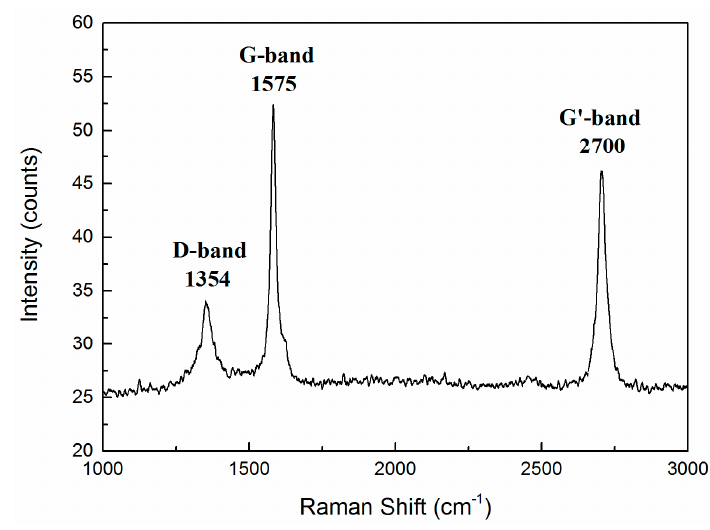
Figure 9. Raman spectra (wavelength λ L = 514 nm) of the carbon species exhibiting a D-band at 1354 cm − 1 , G-band at 1575 cm − 1 , and G’-band at 2700 cm − 1 .